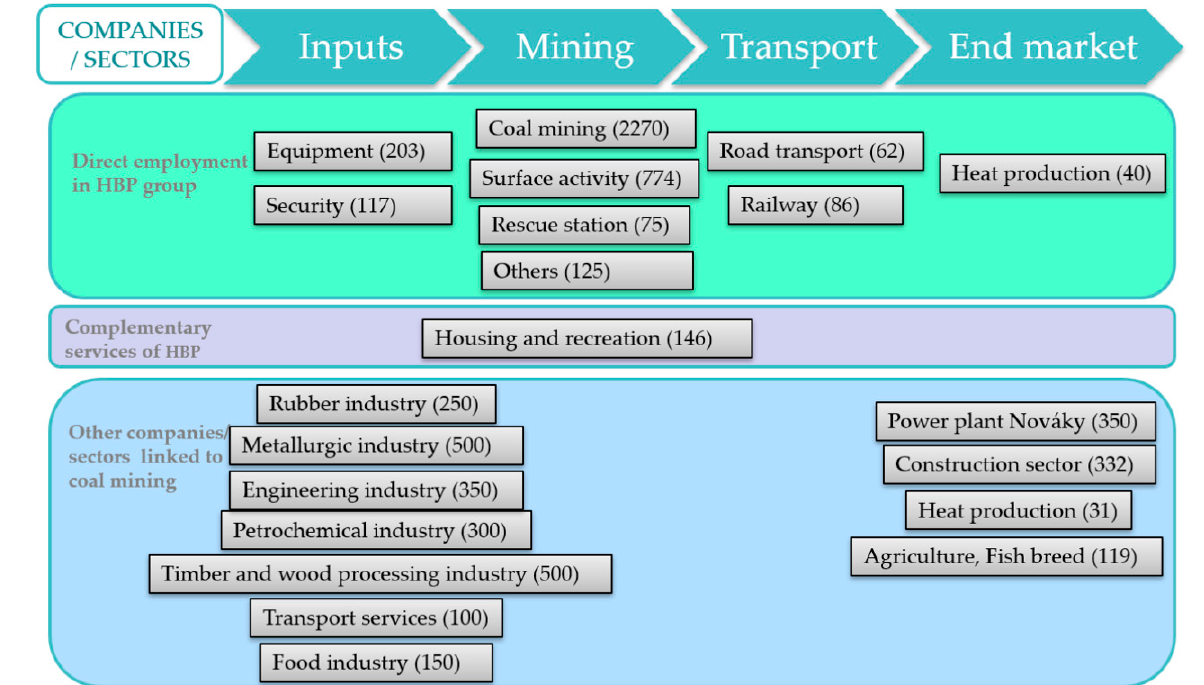
Figure 3. Number of employees per each segment of the coal value chain in Upper Nitra.